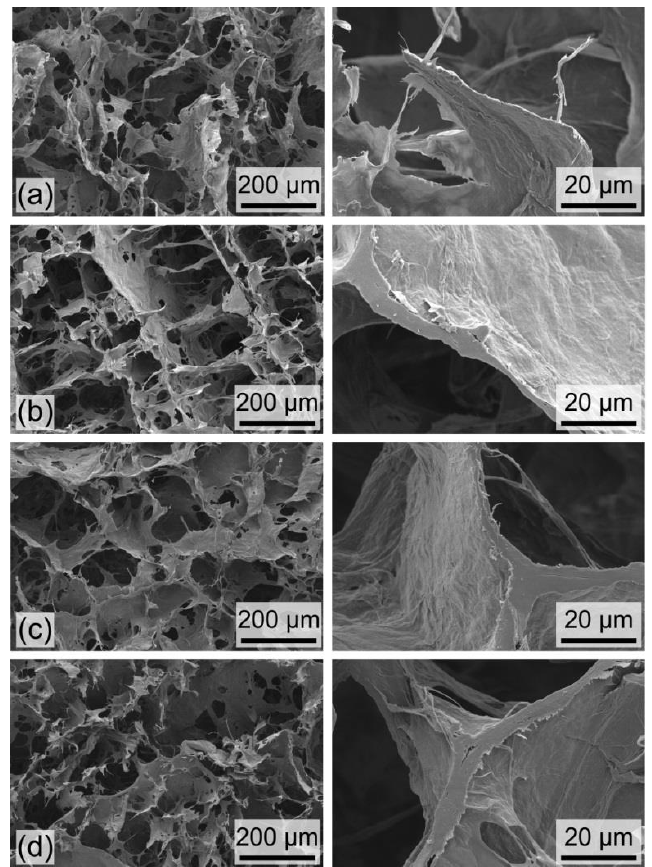
Figure 3. SEM images of cellulose foams produced via the stirred freezing process with different CNF concentrations: ( a ) 0.69 wt%, ( b ) 1.16 wt%, ( c ) 2.03 wt%, and ( d ) 2.39 wt%. Images in the left column highlight the characteristic porosity, with pore sizes in the order of 100 µm; images in the right column zoom in on representative wall thicknesses; these are in the range 1 – 10 µm and increases for increasing CNF concentration.